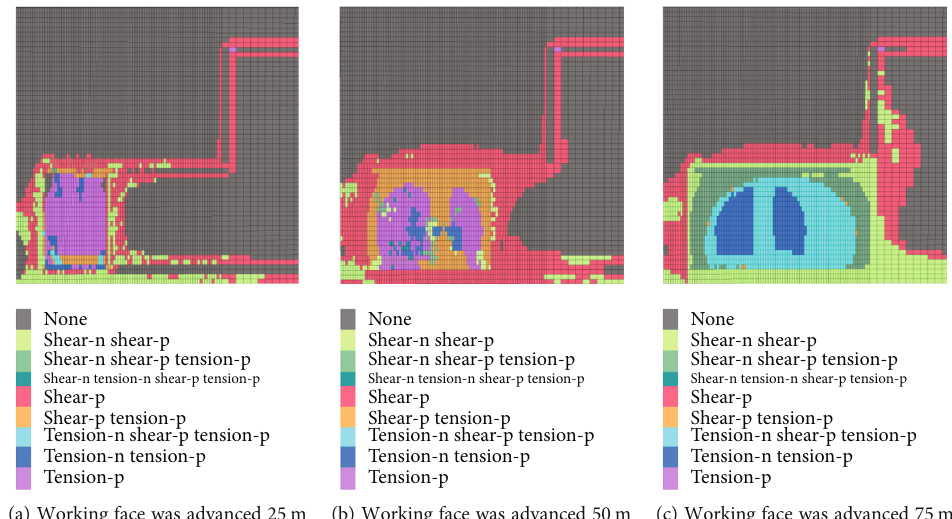
Figure 25: Development of plastic zone in small mining stope.